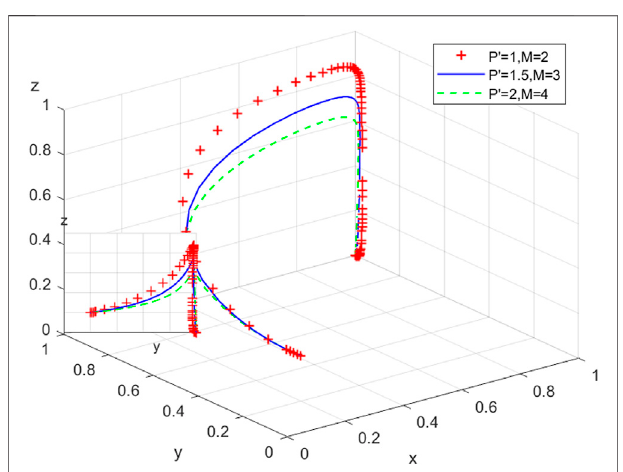
FIGURE 12 | Impact of the supervision cost of the LGs on MEs on the evolution track of the tripartite evolutionary game.